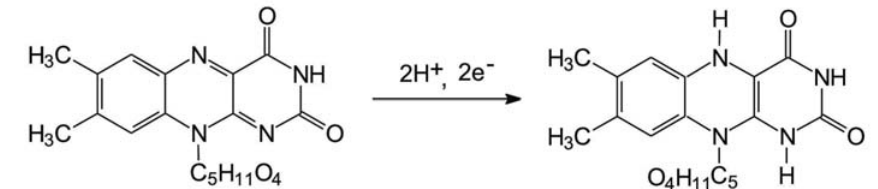
Figure 2. The electro-reduction mechanism for riboflavin.